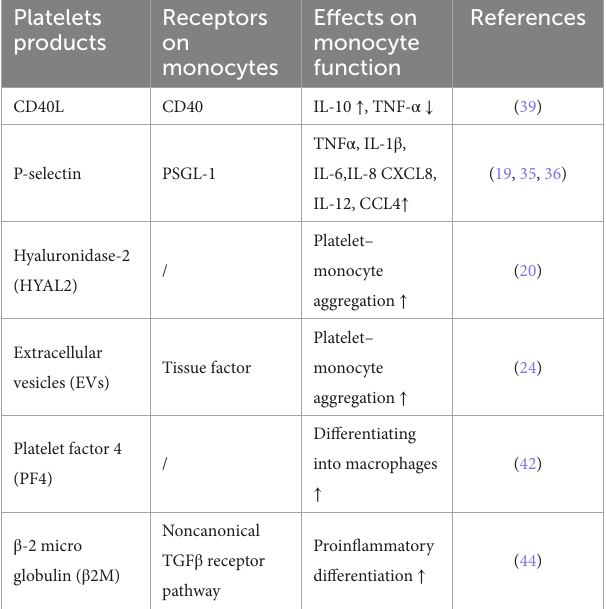
TABLE 2 Platelet-derived molecules affect the function and differentiation of monocytes. Platelets